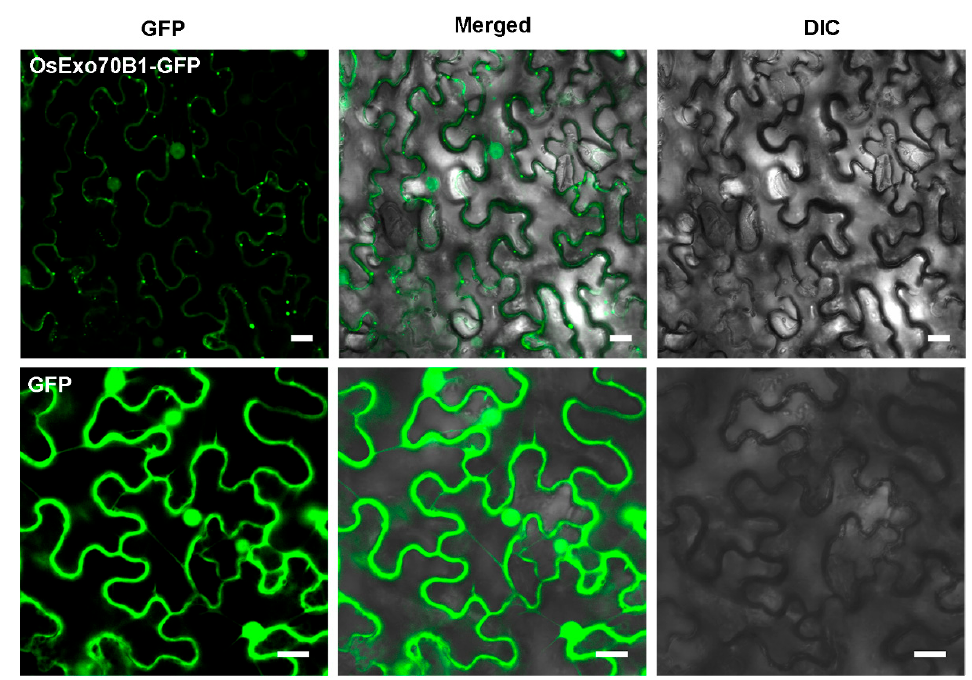
Figure 2. Subcellular localizations of OsExo70B1 .